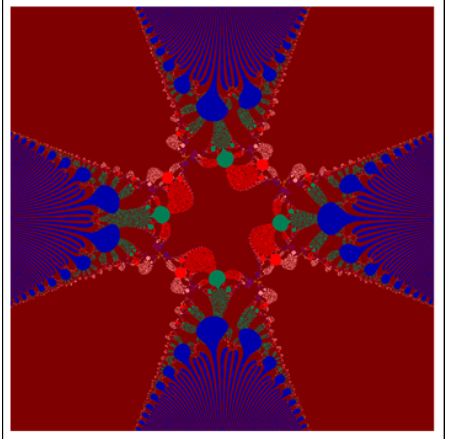
Figure 22. J-set via F-iterative scheme for e z 4 + ( − 0.1 i ) with image visual time = 1270 s.